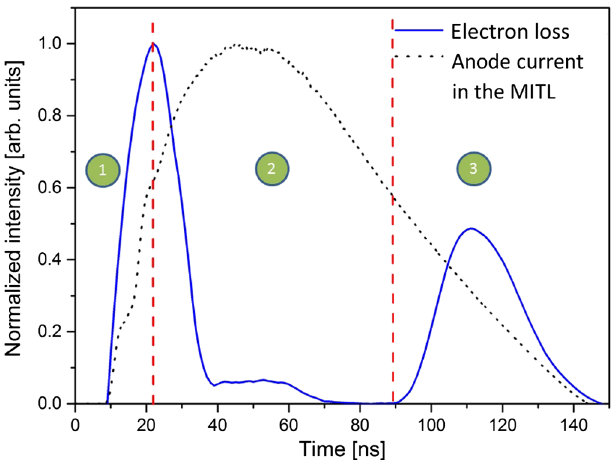
FIG. 12. In blue, temporal evolution of the electrons impacting the outer diameter of the MITL (at R ¼ 23 . 45 cm) integrated across z . In black, temporal evolution of the normalized anode current in the MITL after the tenth cavity.